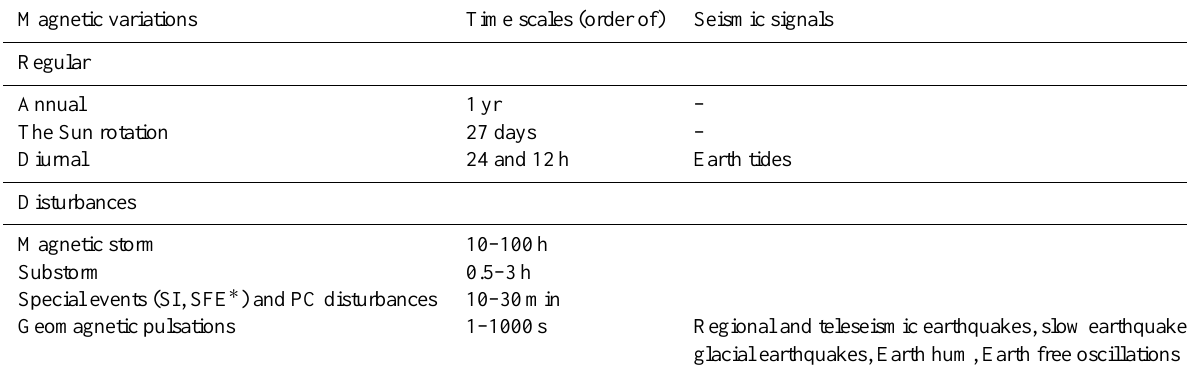
Table 1. Temporal scales of variations of geomagnetic field and seismic